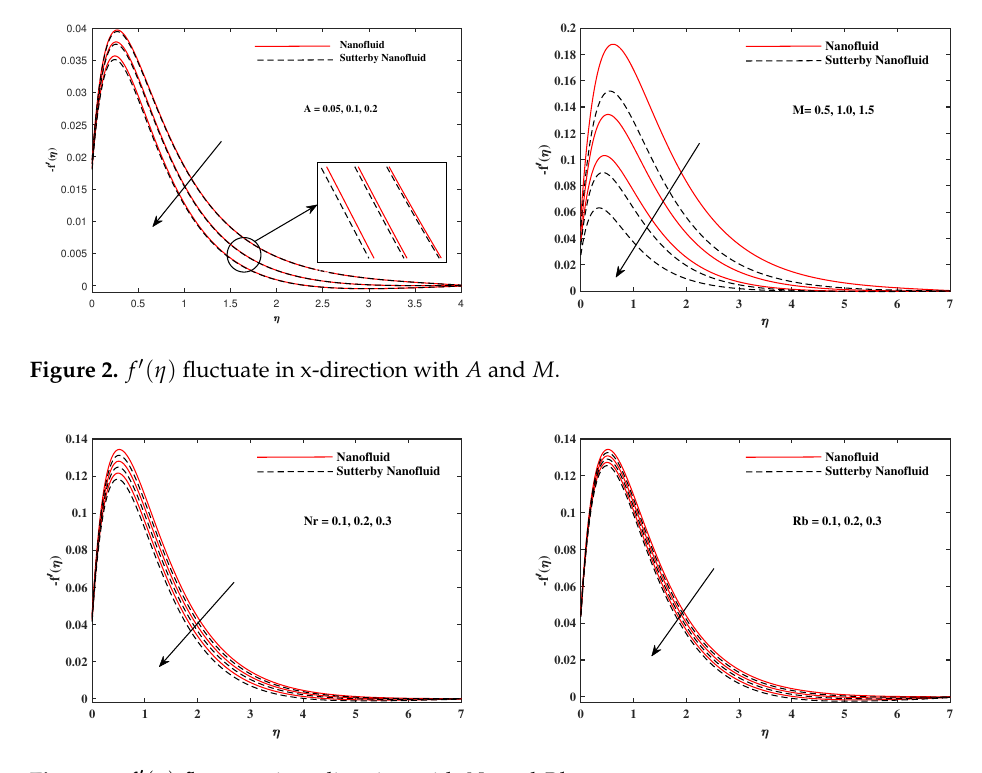
Figure 3. f (cid:48) ( η ) fluctuate in x-direction with Nr and Rb .